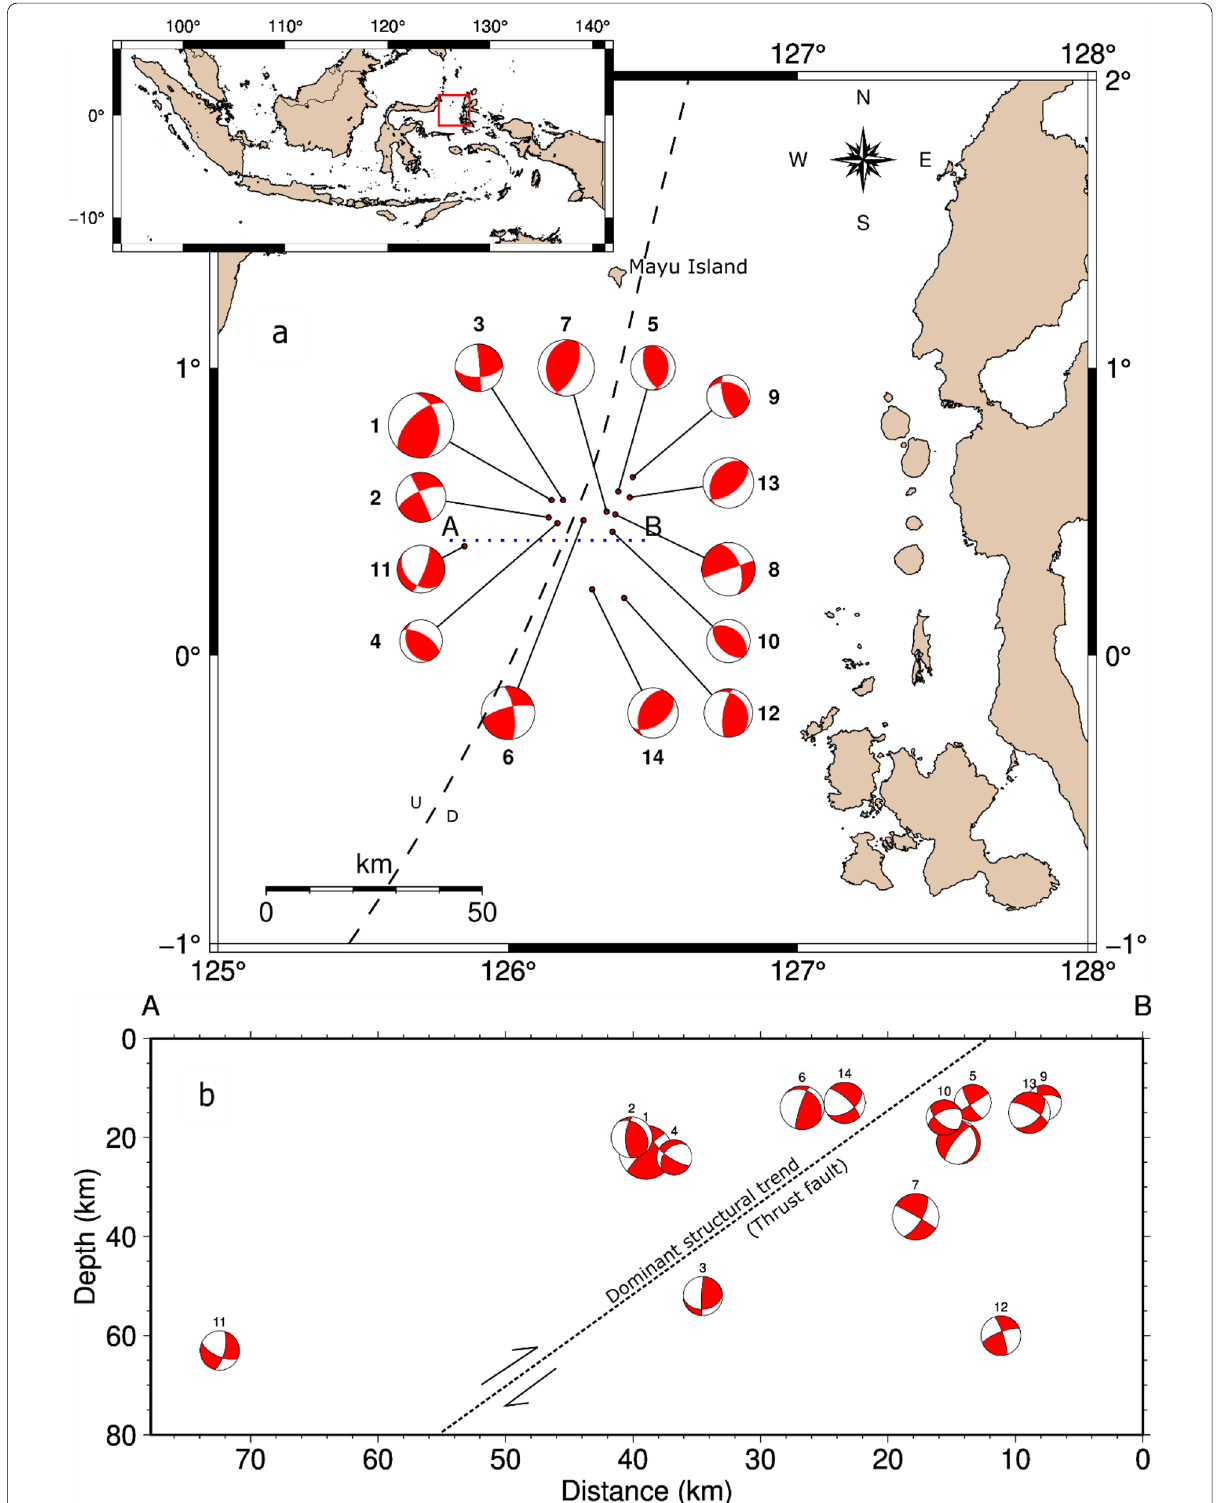
Fig. 5 The fault-plane solutions of all earthquakes in this study. a The numbers indicate the events as referred to in Table 1. The red rectangle in the inset map presents the study area. The dominant focal mechanisms have the dominant relative structural plane of northeast-southwest azimuth. b The A-B cross-section shows the dominant geological structure trend of the thrust fault marked by the dash